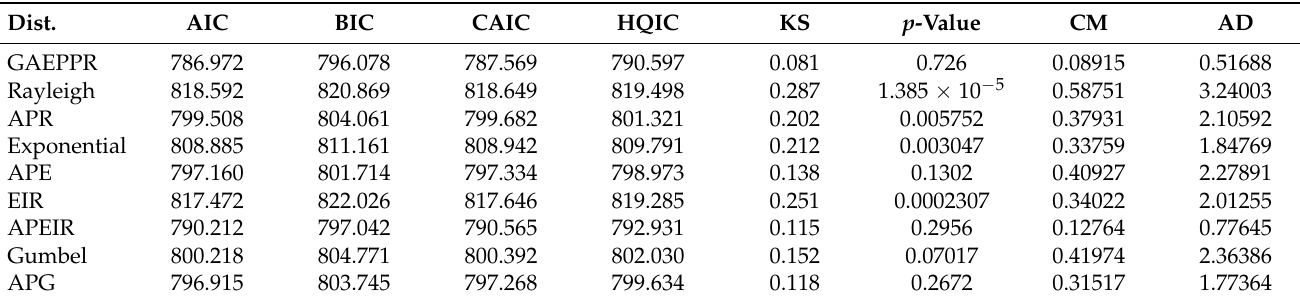
Table 4. DMs and GFMs of the competing models for strength glass fiber